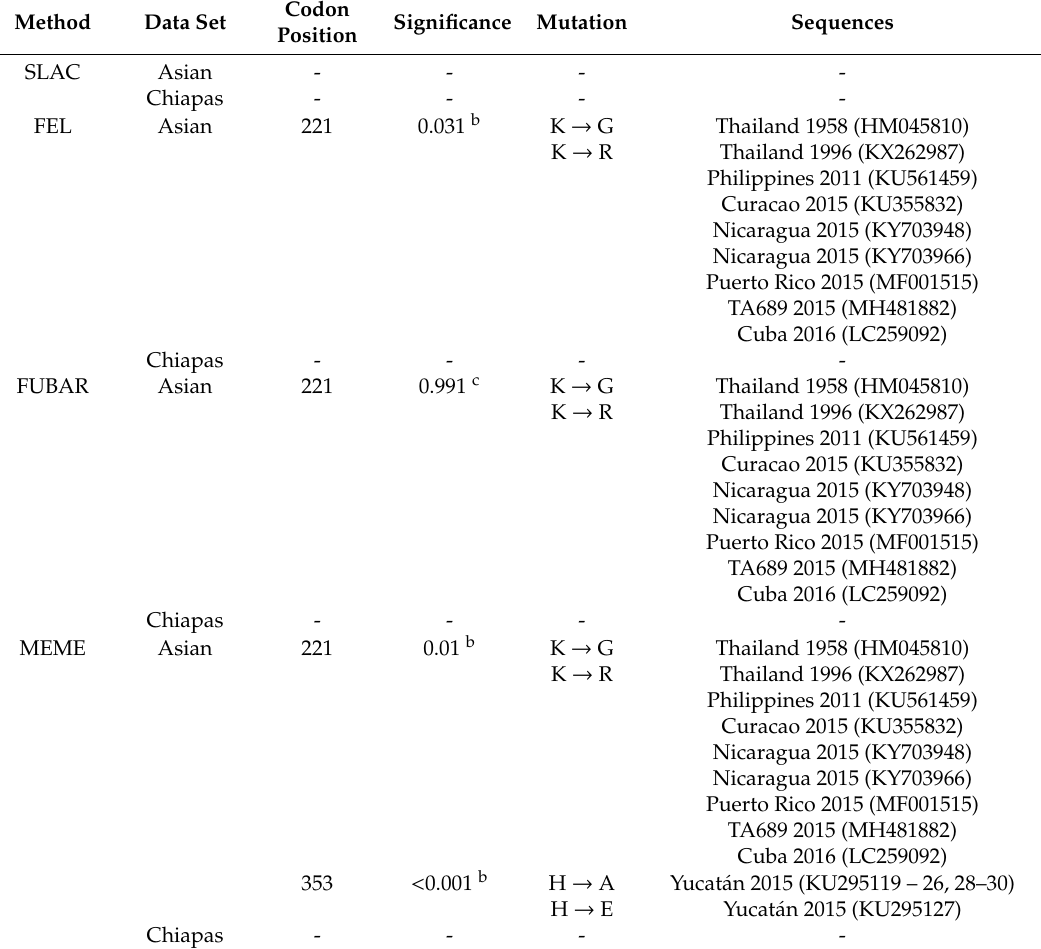
Table 1. Positive selected sites in E2 gene in the studied CHIKV Asian lineages a